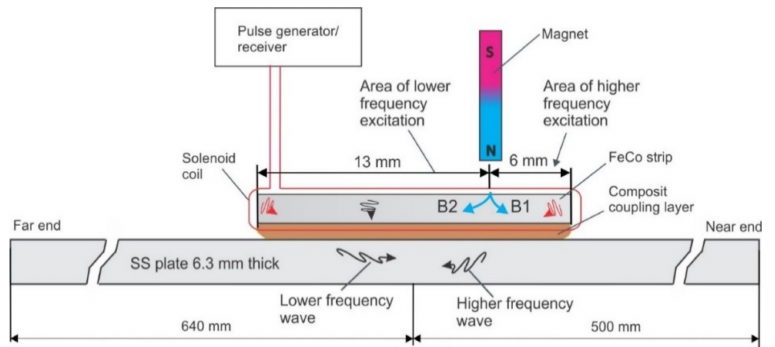
Figure 10. Unidirectional MsT probe arrangement—the ferromagnetic strip is magnetized by a permanent magnet offset from the strip center.